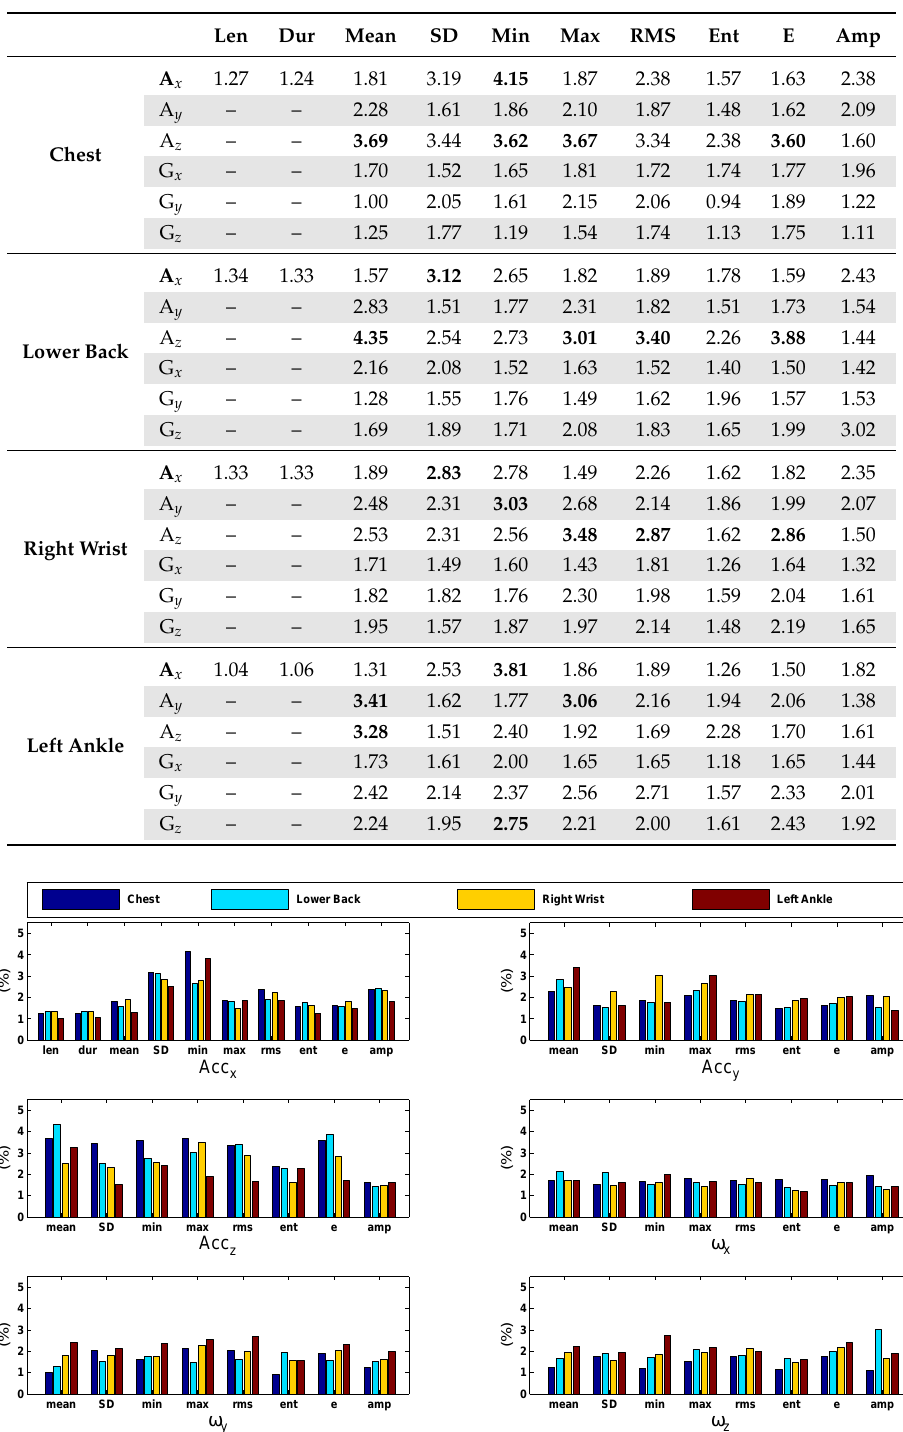
Table 8. Features’ importance computed during body height classification using the 10-fold cross-validation strategy. The top 5 contributing features are highlighted with bold text. All values are the percentage.